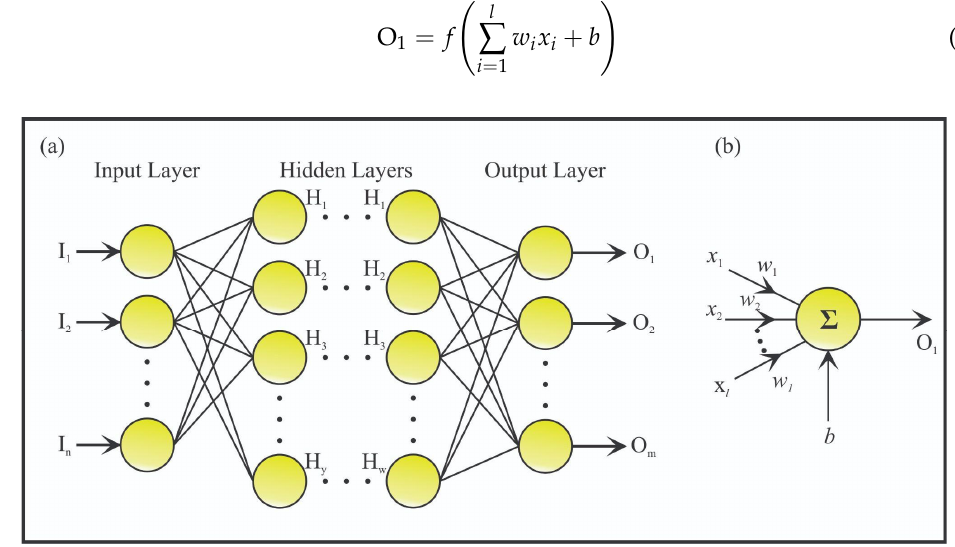
Figure 1. ANN architecture: ( a ) ANN with hidden layers and ( b ) a single neuron.